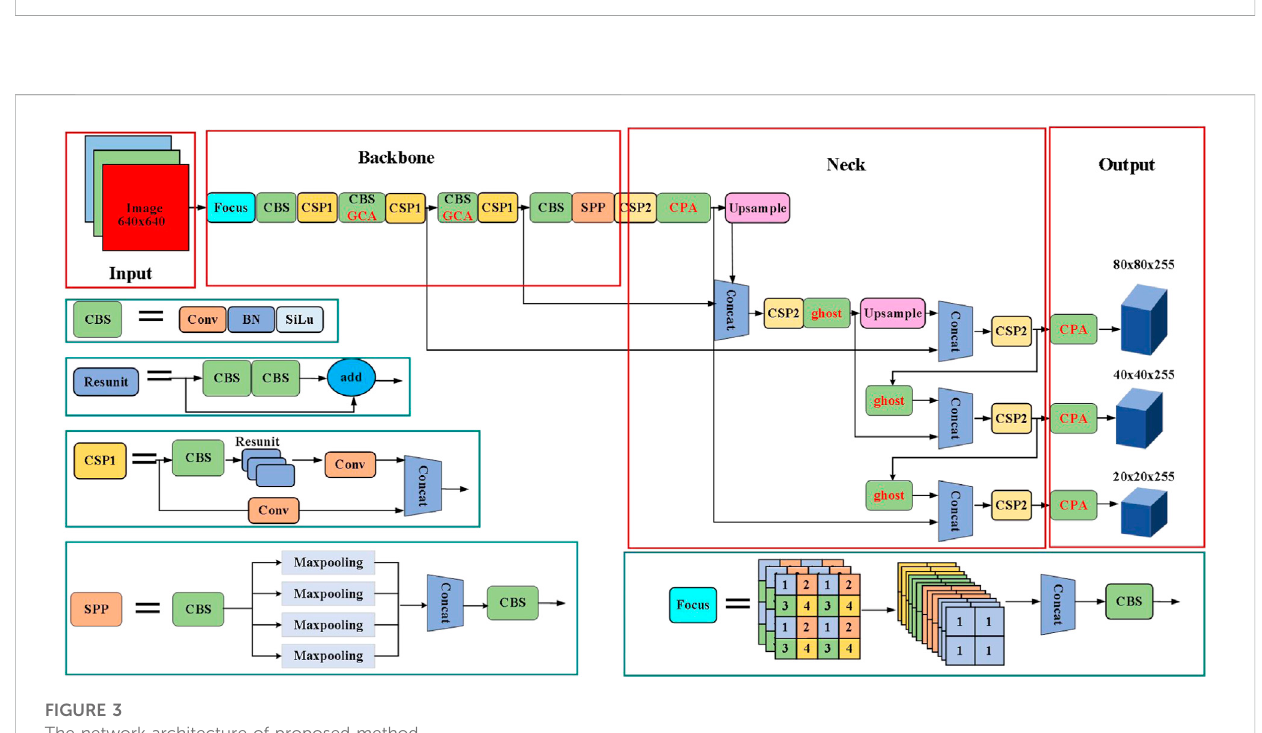
FIGURE 3 The network architecture of proposed